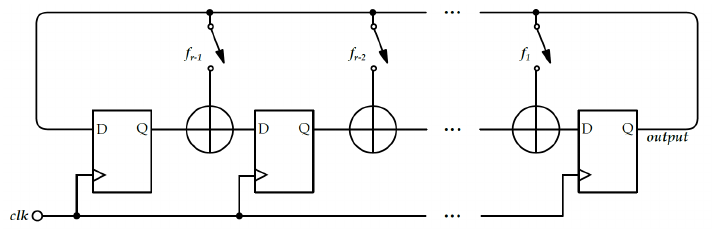
Figure 4. Galois Linear Feedback Shift